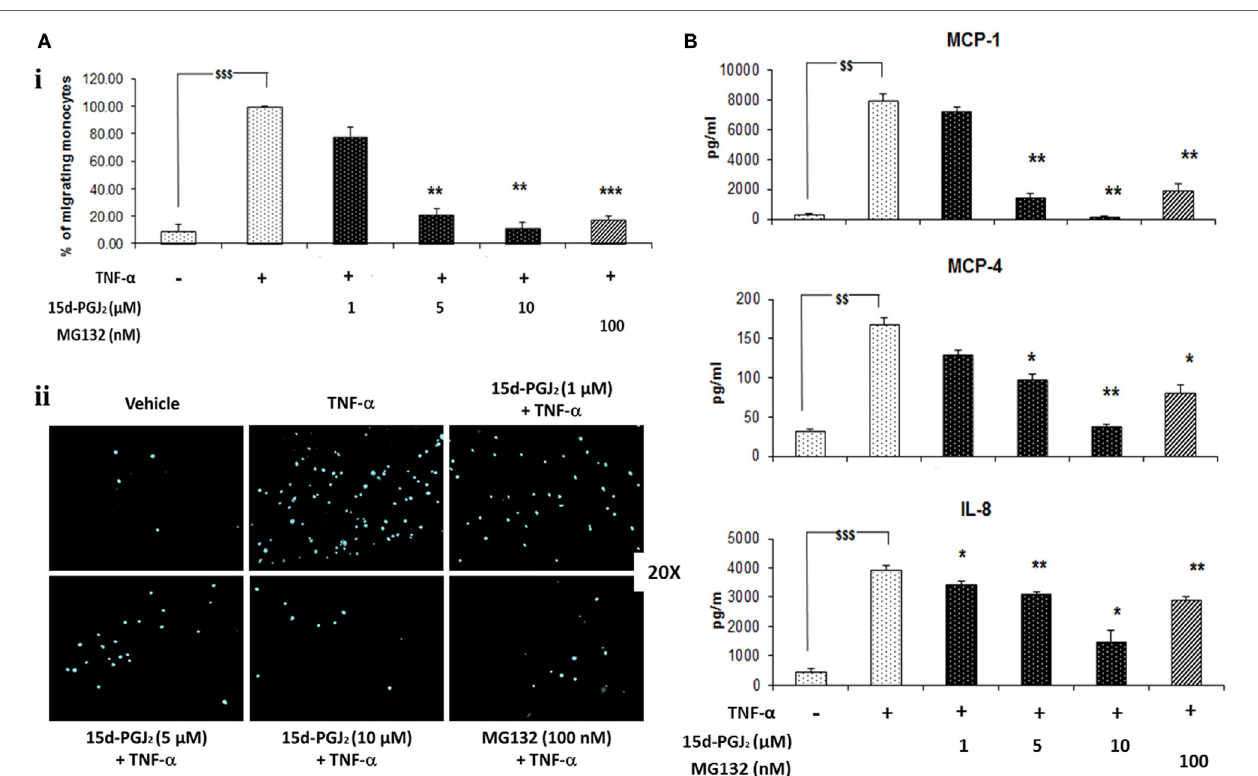
FigUre 6 | 15d-PgJ 2 inhibits ec-conditioned-media-induced monocyte migration . (a) (i) THP-1 monocyte migration in response to conditioned medium from EC that had been treated with 15d-PGJ 2 (1–10 μ M) or MG132 (100 nM) and activated with TNF- α was assayed using a 24-well transwell migration plate. Migrating cells were stained with DAPI and visualized using a fluorescent microscope. The number of cells in five random 20 × fields was counted, and the average value was expressed as a percentage of TNF- α -activated EC. (ii) Representative fluorescence microscopy photomicrographs of migrating monocytes are shown. Each experiment was carried out independently three times. Data were calculated as mean ± SEM of three independent experiments and reported as percentage of TNF- α -activated EC; $$$ ( p < 0.001) vehicle vs. TNF- α ; *** p < 0.001 and ** p < 0.01 treatments vs. TNF- α alone. (B) 15d-PGJ 2 suppresses chemokine generation. Conditioned-media from EC treated with 15d-PGJ 2 (1–10 μ M) or MG132 (100 nM) and activated with TNF- α was assayed to measure IL-8, MCP-1, and MCP-4 levels by ELISA. The results are from three independent experiments. Data were calculated as mean ± SEM and reported as percentage of TNF- α -activated EC; $$$ ( p < 0.001), $$ ( p < 0.01) vehicle vs. TNF- α ; ** p < 0.01 and * p < 0.05 treatments vs. TNF- α